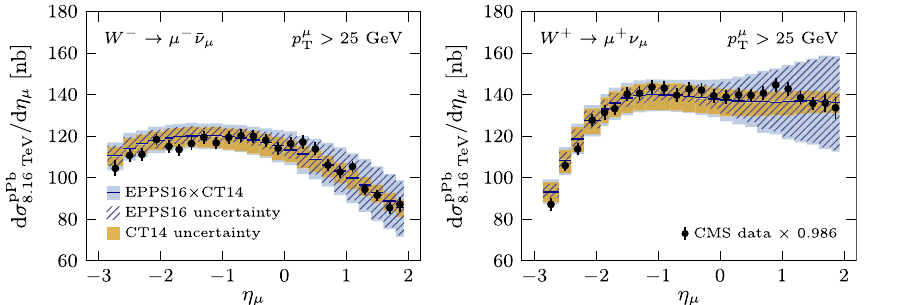
(EPPS16, blue hatching). The data from the CMS measurement [26] are presented with black markers, scaled with the optimal normaliza- tion factor explained in the text